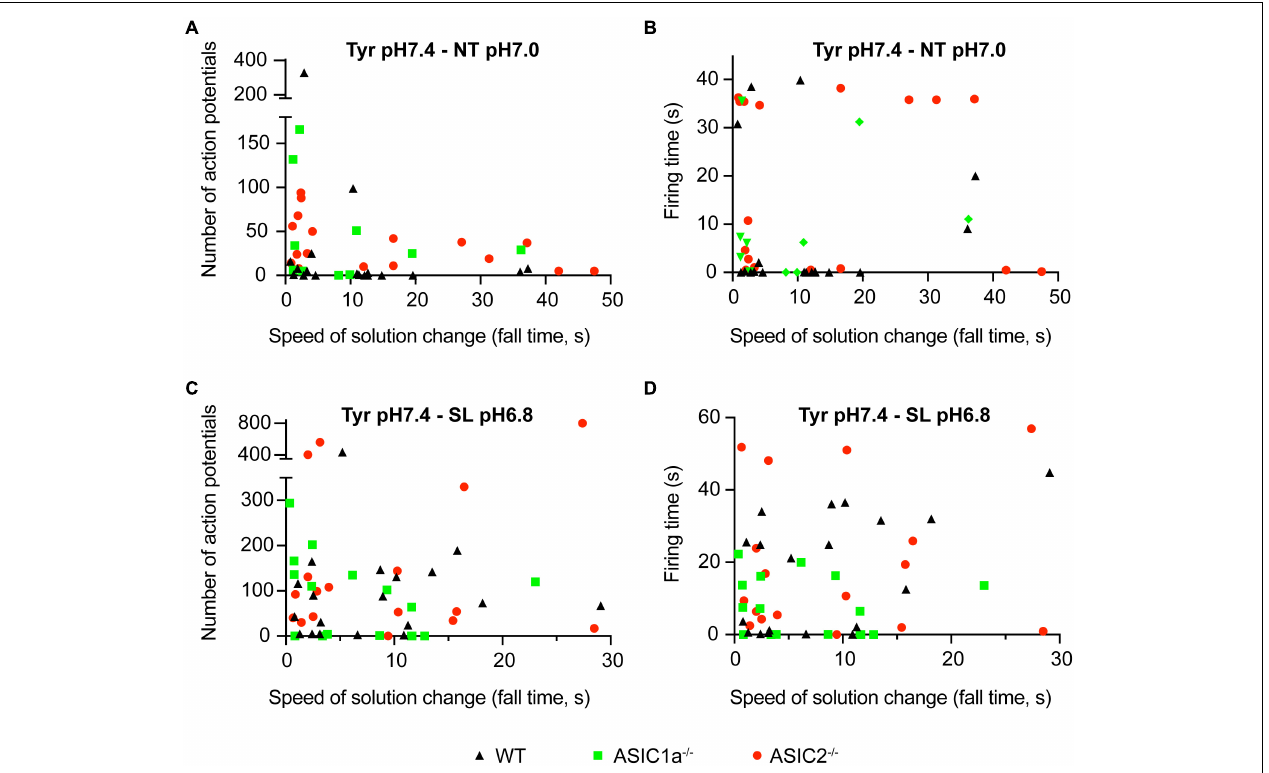
FIGURE 2 | Dependence of AP number and firing time on the kinetics of solution change. Current-clamp experiments with cortical neurons. Baseline current was injected to obtain a resting membrane potential close to –60 mV in the pH7.4 Tyr solution. In these experiments the solution was changed from Tyrode solution at pH7.4 to either NT solution at pH7.0 or SL solution at pH6.8. In the Tyr solution, Ca 2 + and K + concentrations are 2 and 4 mM, respectively, while they are 1 and 6 mM in the NT and 0.8 and 8 mM in the SL solution. Number of APs (A,C) and the firing time (FT; B,D ) are plotted as a function of ramp fall time of the solution change, as indicated; n = 12–21 per genotype and condition. The FT was determined as the time between the start of the first and the end of the last